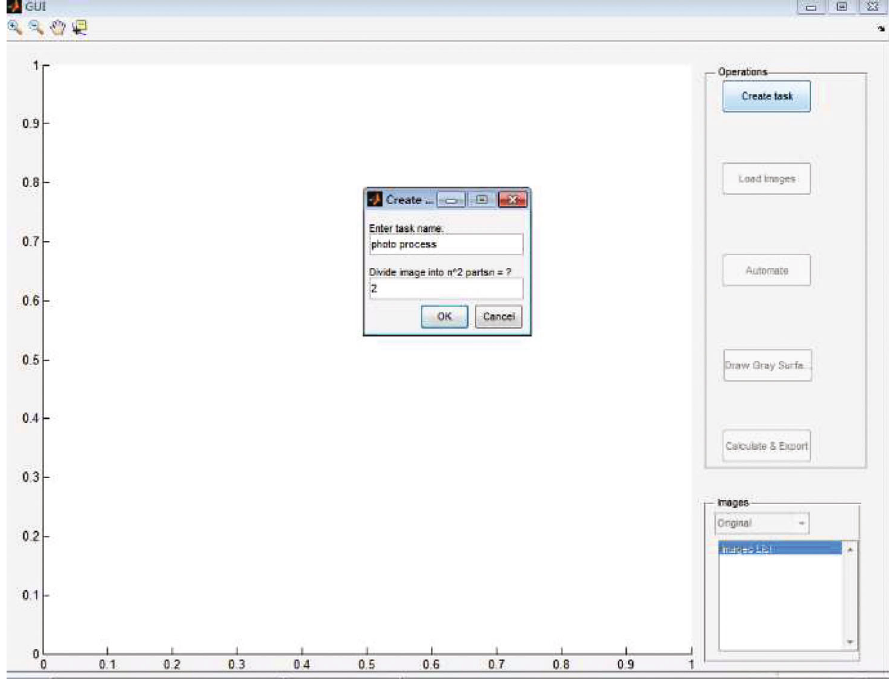
Figure 7: Main interface of the calculation program. Table 1: Depth of departure coe ffi cient of variation for digital image construction of AC-20 asphalt mixture